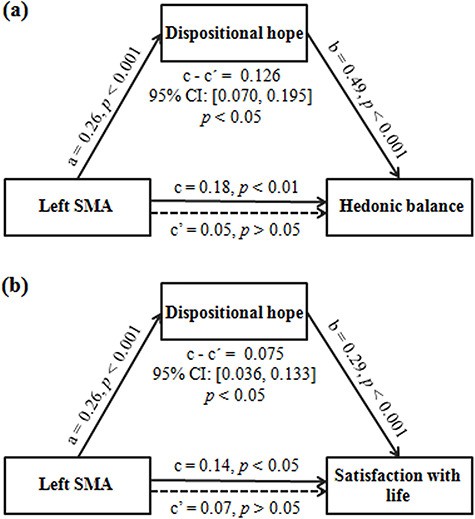
Dispositional hope mediates the effect of left SMA volume on hedonic balance (a) and satisfaction with life (b). Standardized regression coefficients are presented in the path diagrams. Sex, age, family SES and total GMV are controlled for in the models.